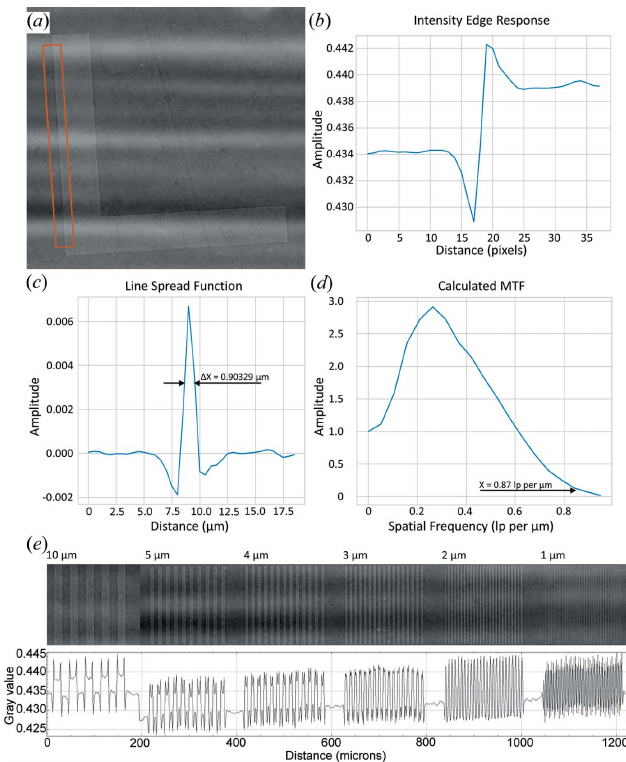
Figure 5 Slanted edge response and calculation of MTF in the projection domain. A 400 projection series taken at the same angle of the indicated area of the slanted L edge ( a ) was used to record the associated averaged intensity line profile ( b ). The LSF ( c ) was taken as the first derivative of ( b ) across pixel distance, and the MTF ( d ) was calculated as the discrete normalized Fourier transform of the portion of ( c ) covering the edge. The full width at half-maximum amplitude of the LSF was recorded at 0.90 m m ( c ), with the indicated 0.1 MTFamplitude located at 0.87 line pairs per m m ( d ). Line pairs are presented with a corresponding averaged intensity line profile indicating contrast within the 10, 5, 4, 3, 2 and 1 m m line pair groups ( e ). Edge enhancement can be visualized most easily in the intensity profile region corresponding to the 10 m m